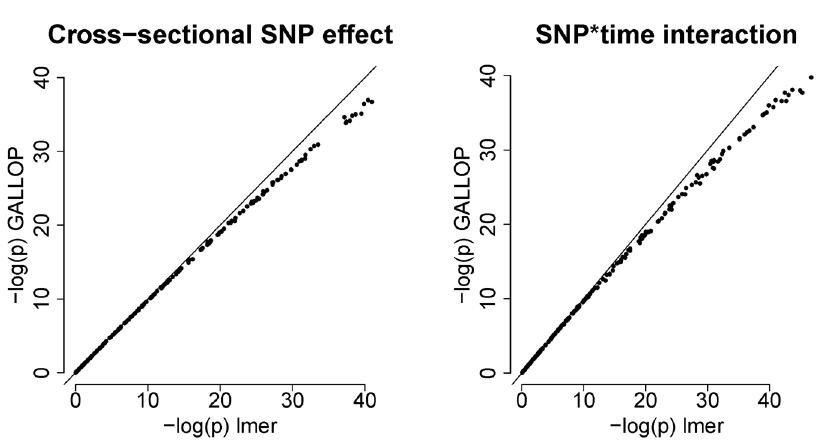
Figure 2. Simulation study. Accuracy of the coefficients computed by GALLOP compared to lmer .